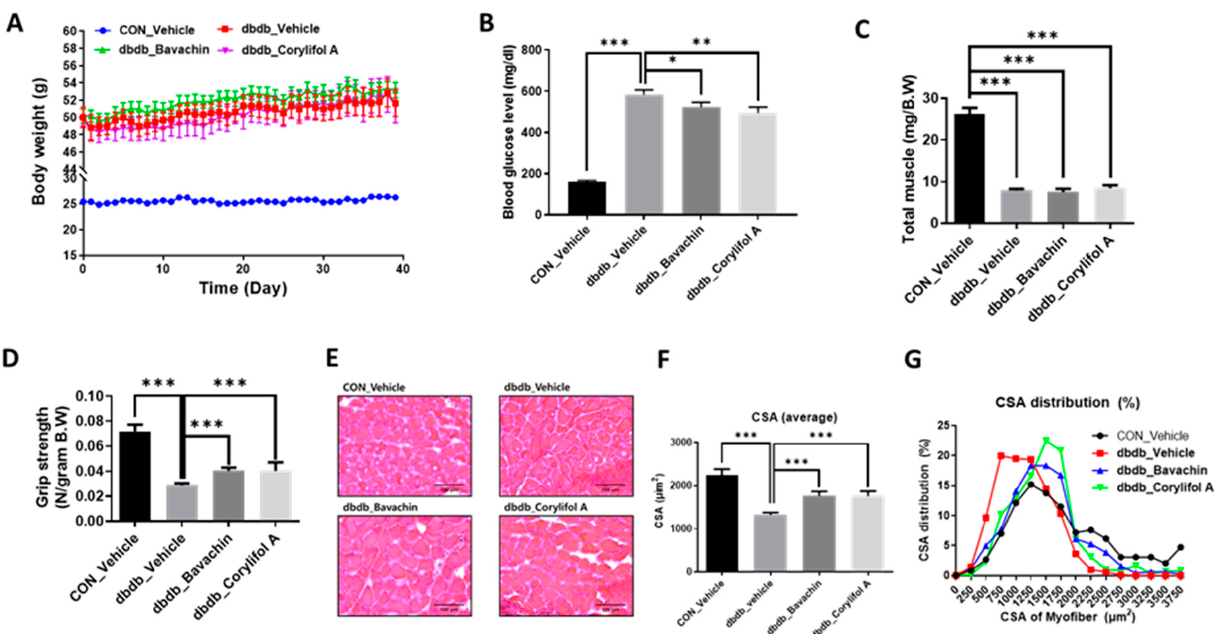
Figure 2. Bavachin and corylifol A increase the muscle strength in diabetic (db/db) mice. Twelve week old male db/db mice were administered bavachin (10 mg/kg) or corylifol A (10 mg/kg) for 40 d. ( A ) Body weight changes in mice, and ( B ) non-fasting blood glucose levels. ( C ) Total muscle weight. ( D ) Grip strength. ( E ) Representative images of CSA of GA muscle tissue at 200× magnification. ( F ) Average CSA of muscle fibers. ( G ) CSA distribution of muscle fibers. CSA data were measured using the ImageJ software. All data are represented as the mean ± S.E.M., n = 6–7/group; * p < 0.05, ** p < 0.01, *** p < 0.001; nonparametric analysis of variance, followed by Kruskal-Wallis test.